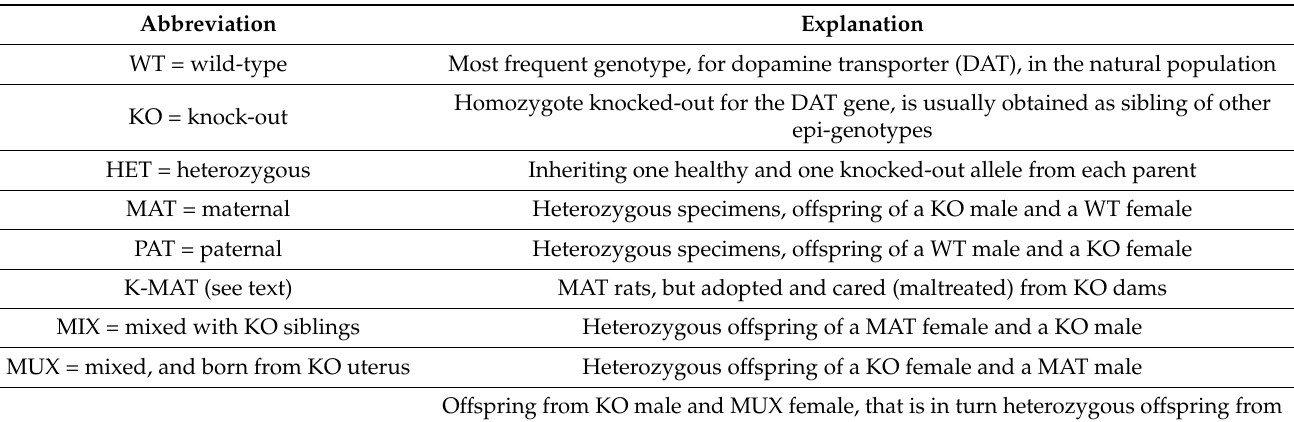
Table 1. Epigenotypes: abbreviations’